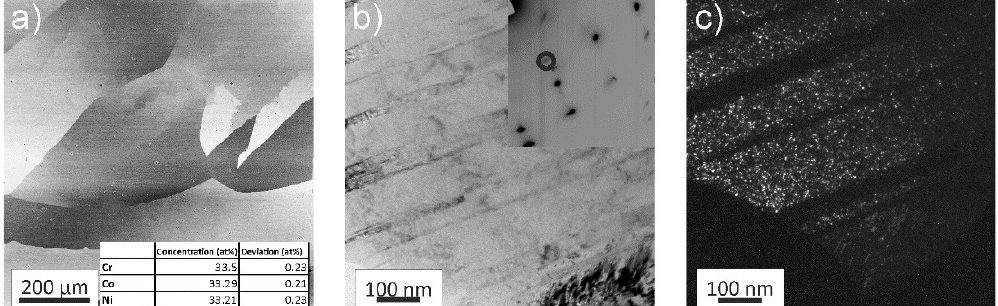
Figure 1. ( a ) Back-scattered electron (BSE) image of the coarse-grained as-received microstructure. The inset shows the chemical composition as determined by scanning electron microscope (SEM)-energy-dispersive X-ray (EDX). High-magnification bright-field (BF) image in the transmission electron microscope (TEM) of the same microstructure state; ( b ) The inset depicts an electron-diffraction pattern, showing the presence of a minority phase. The circle marks the selected diffracted beam used for the dark-field (DF) image shown in ( c ), where the nanoscale minority phase can be